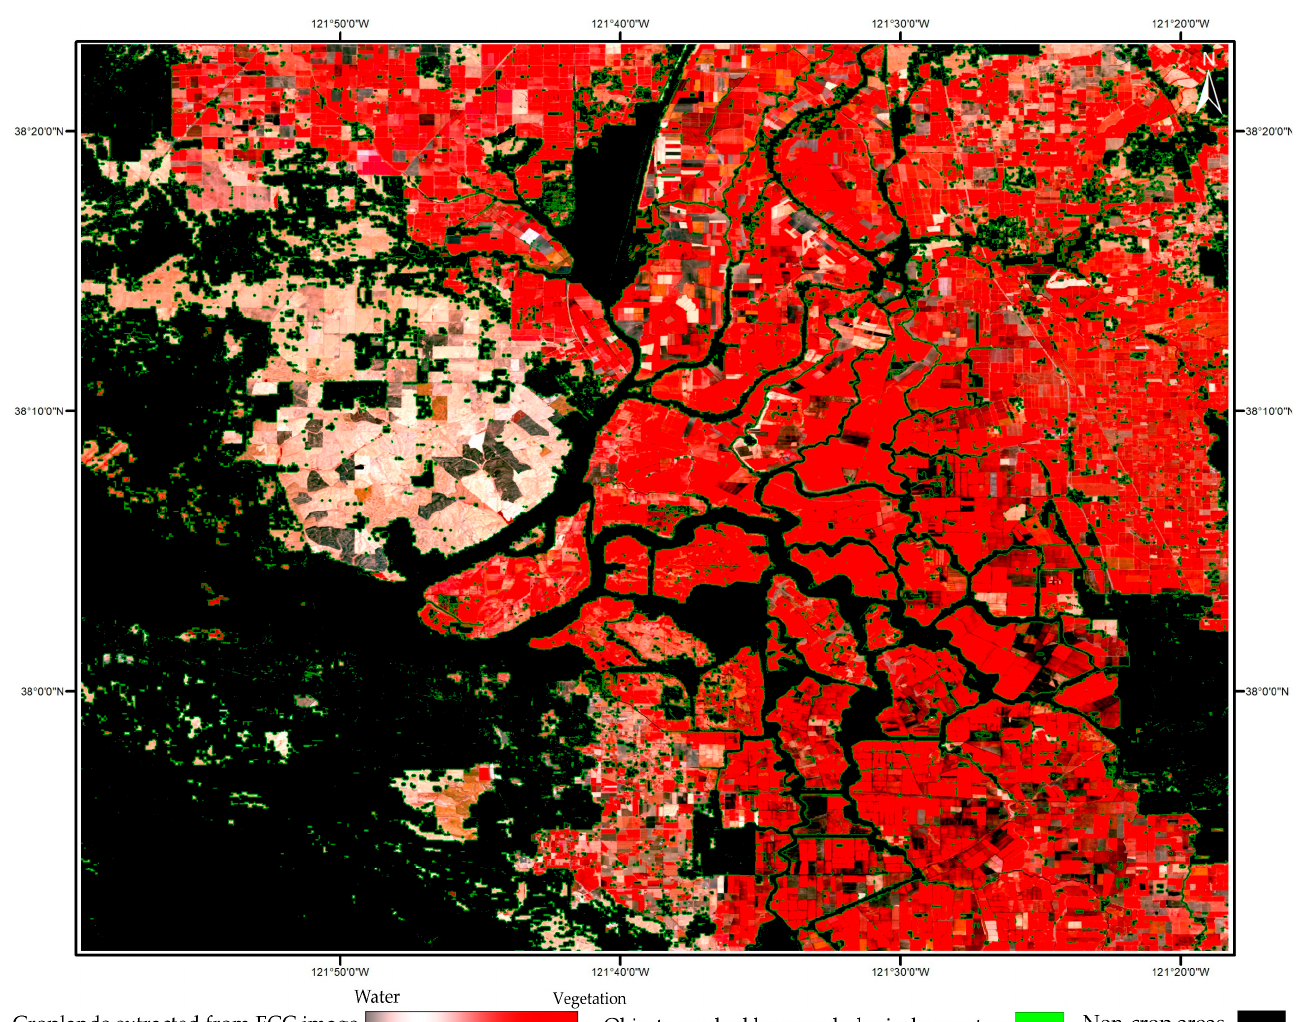
Figure 3. Output when using morphological operators (3 × 3) for the US-TW3 station. This map illustrates the crop class which was extracted from False Color Composite (FCC) imagery and subjected to changes with the morphological functions. The green areas include small polygons, single pixels or misclassification errors, linear objects and polygon margins, diminished by the functions of the WF method.